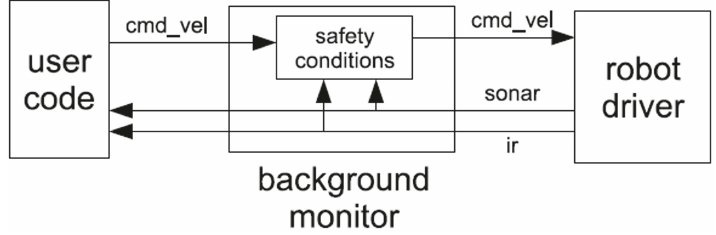
Figure 3: Example of safety monitoring for a mobile robot.